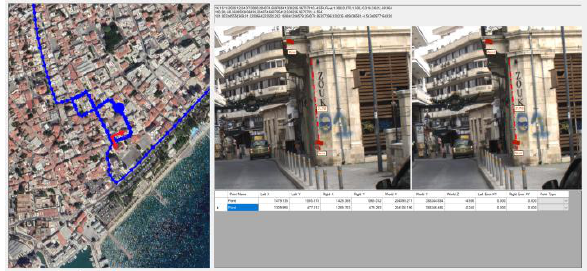
Figure 7: Example screen of data processing